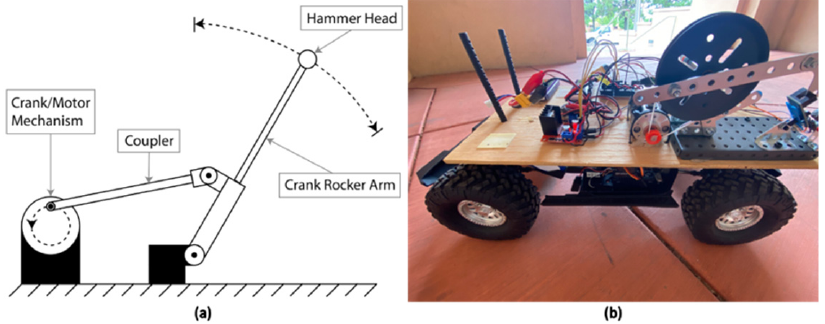
Figure 1. Tapping mechanism ( a ) Side view of Four-Bar Linkage Crank Rocker concept; ( b ) Side view of constructed Four-Bar Linkage Crank Rocker.